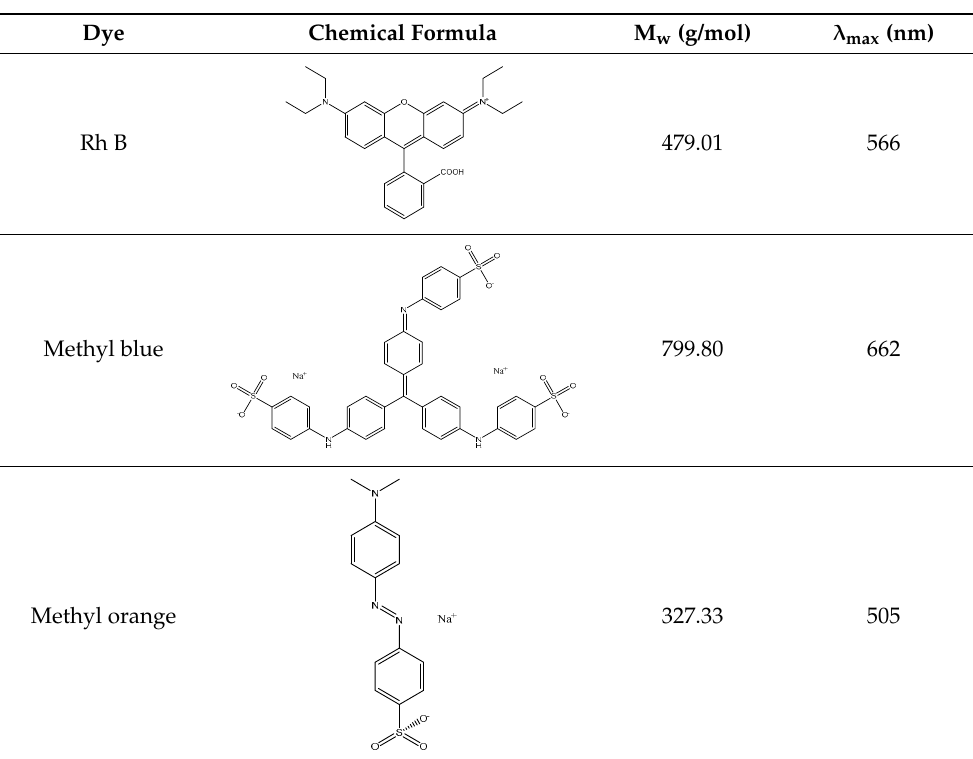
Table 1. Physicochemical characteristics of the three dyes.